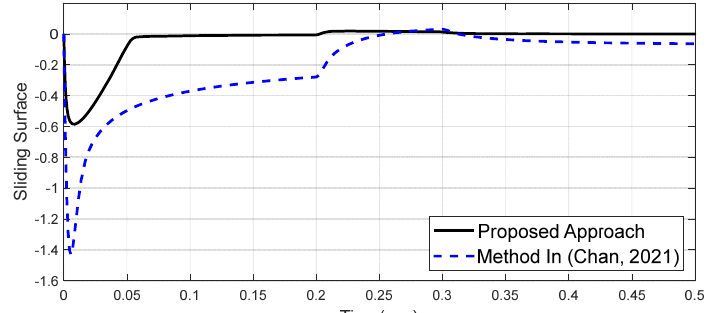
Figure 12. Controller effort signals [1] .